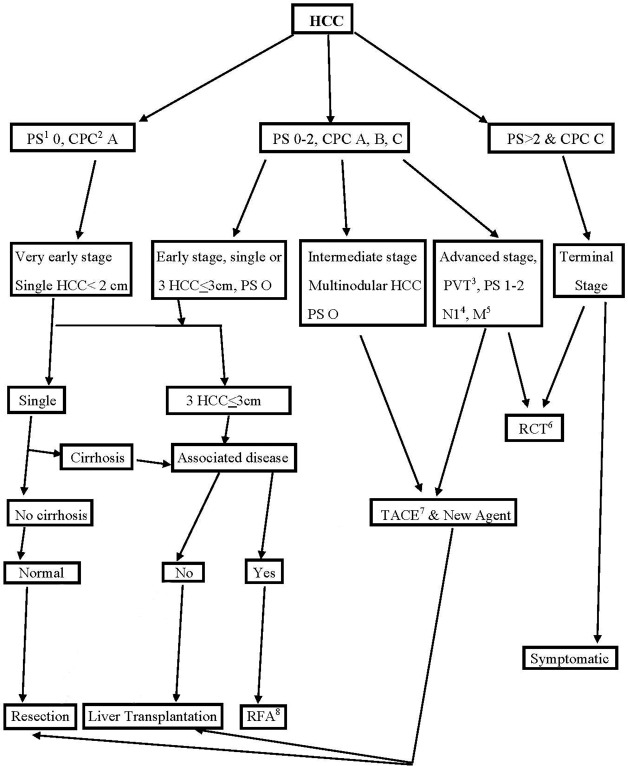
Interventional Oncology guideline of our institute for patients with HCC based on BCLC proposal.(1) Perfomance status, (2) Child Pugh class, (3) Portal vein thrombosis, (4) Nodal metastases at porta hepatis, (5) Metastases, (6) Randomized controlled trial, (7) Doxorubicin drug eluting beads trans-arterial chemoembolization, (8) Radiofrequency ablation.